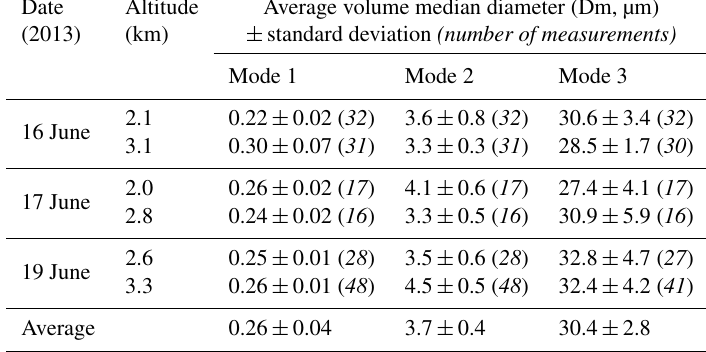
Table 3. Average volume median diameter (Dm) of the three fitted aerosol particle modes and respective standard deviation along BLPB flights at float altitude within dust layers, for the six BLPBs launched from Minorca during the 16–19 June 2013 dust event. The time evolution for the three pairs of BLPB flights during this period is shown in Fig. 16. The average and standard deviation in the bottom line are obtained by averaging the 6 above